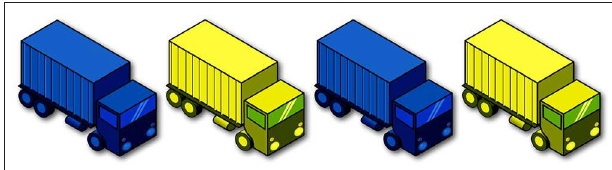
FIGURE 1 | Image corresponding to a GAP context. The first and third trucks are blue, while the second and fourth trucks are yellow.